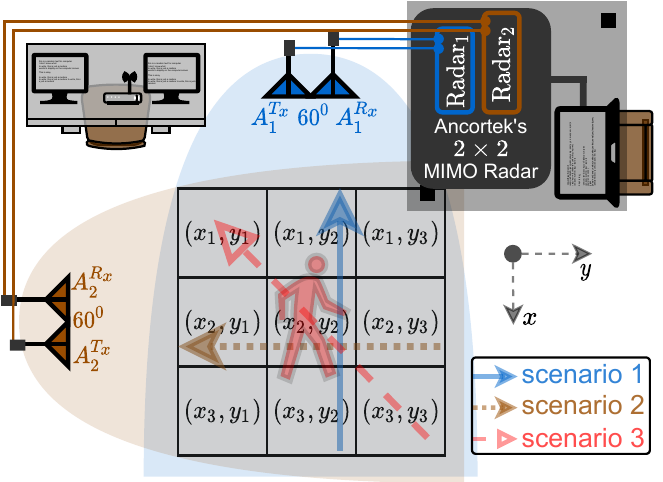
Figure 7. Two radar subsystems forming a 2 × 2 distributed MIMO radar system in the presence of a moving person in a cluttered indoor